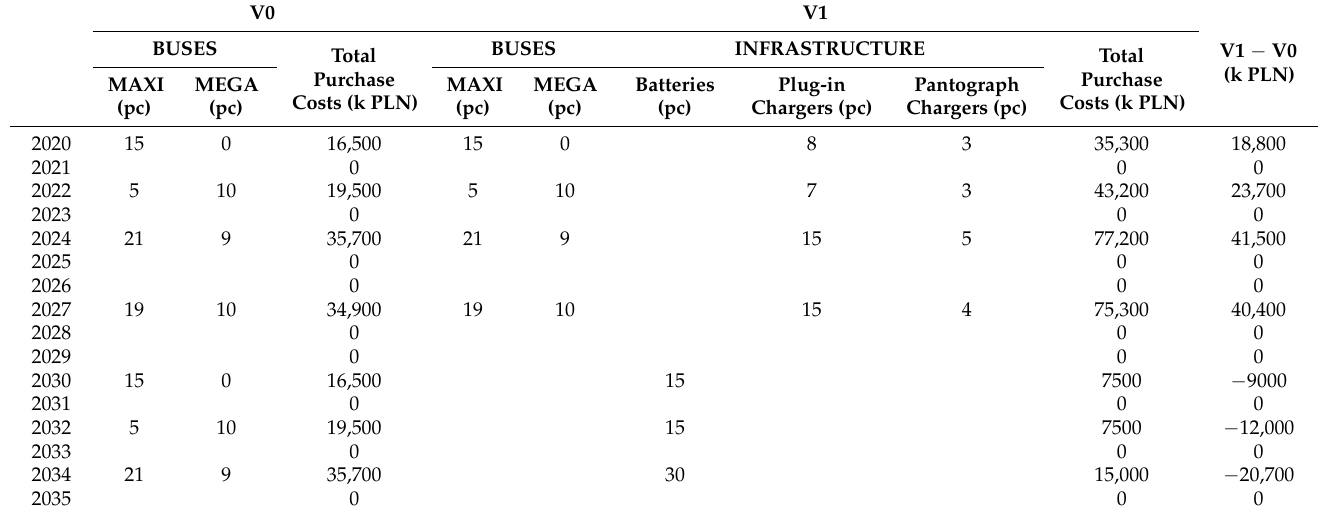
Table 3. Comparing the costs of purchasing the vehicles and supporting infrastructure for variants V0 and V1.